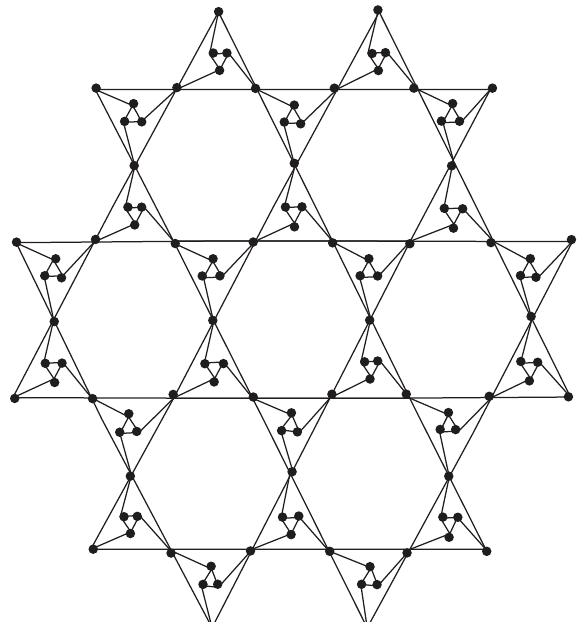
Figure 1: Prism octahedron network P Table 1: Vertex partition of P